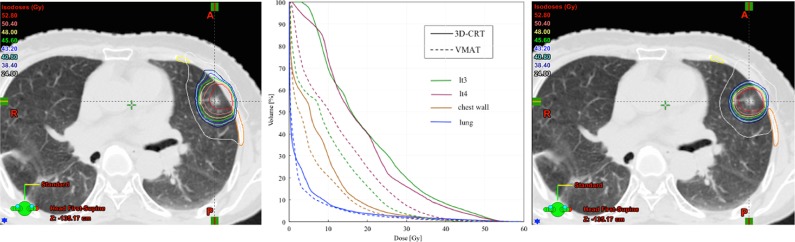
The dose distributions and dose–volume histograms (DVHs) of normal tissues showing 3D-CRT and VMAT plans for one patient with primary cancer in left lung. Dose distribution with 3D-CRT plan (left); dose distribution with VMAT plan (right). Values of CN in 3D-CRT and VMAT plans were 0.57 and 0.79, respectively.ltx = developed RIRF with X-place in left ribs.